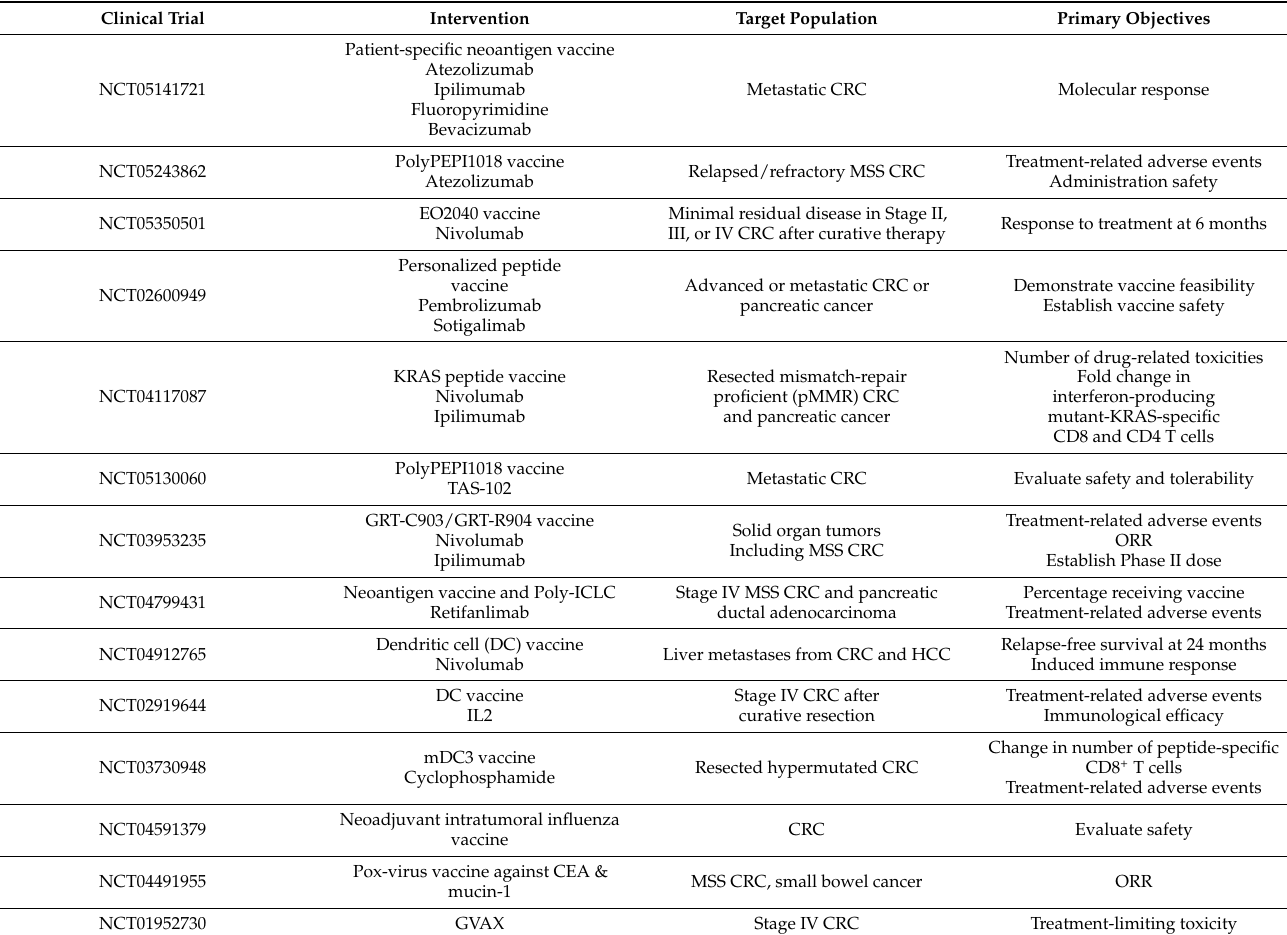
Table 3. Clinical trials evaluating the use of tumor vaccines in